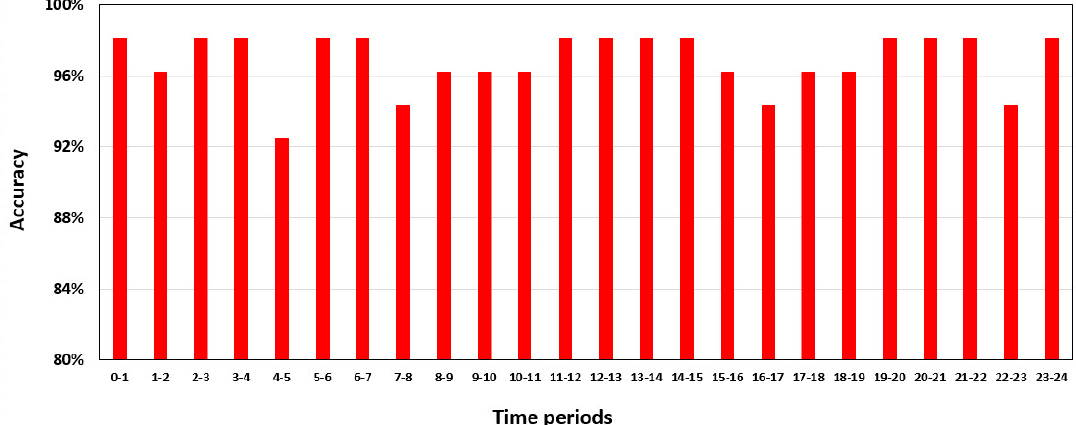
Figure 12. The accuracies of the data set of the COO analyzing network in extended period conditions.